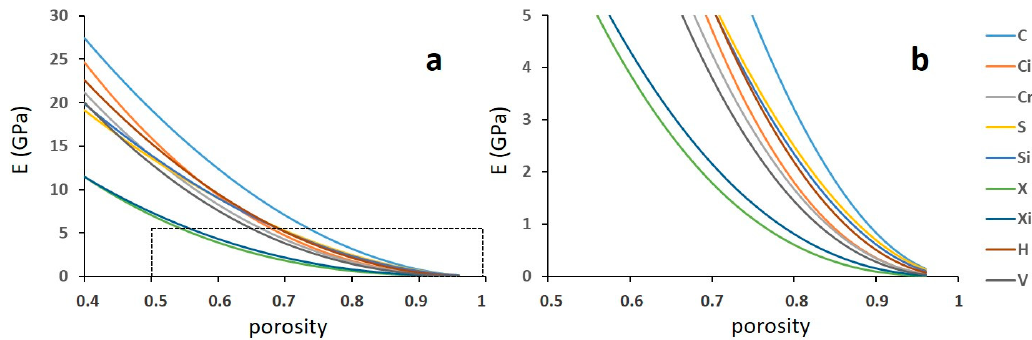
Figure 16. Effect of porosity on the Young’s modulus according to the Gibson–Ashby model. The letters refer to structures. The graph ( b ) is an enlarged inset of the dashed area in the graph ( a ).